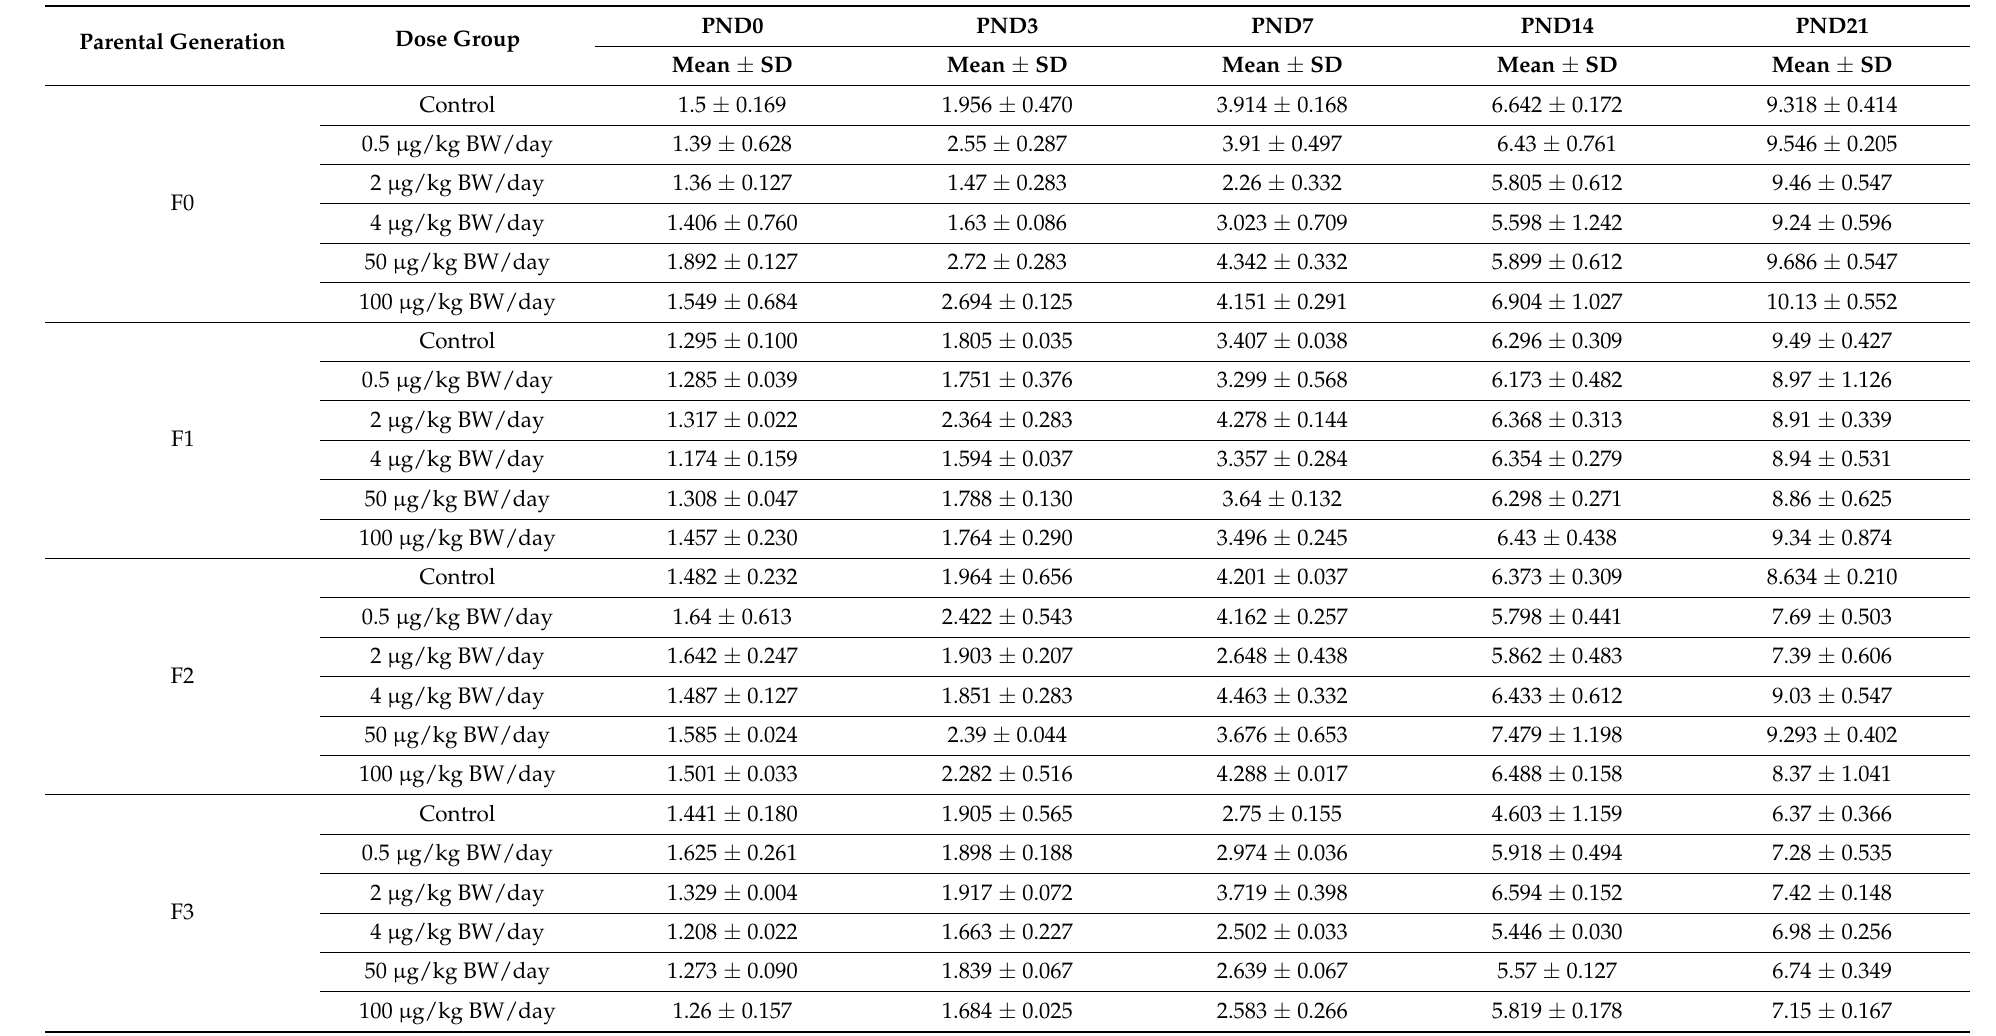
Table 5. Mean weights ± standard deviations of the litters at days 0, 3, 7, 14, and 21 after the birth according to the parental generation of